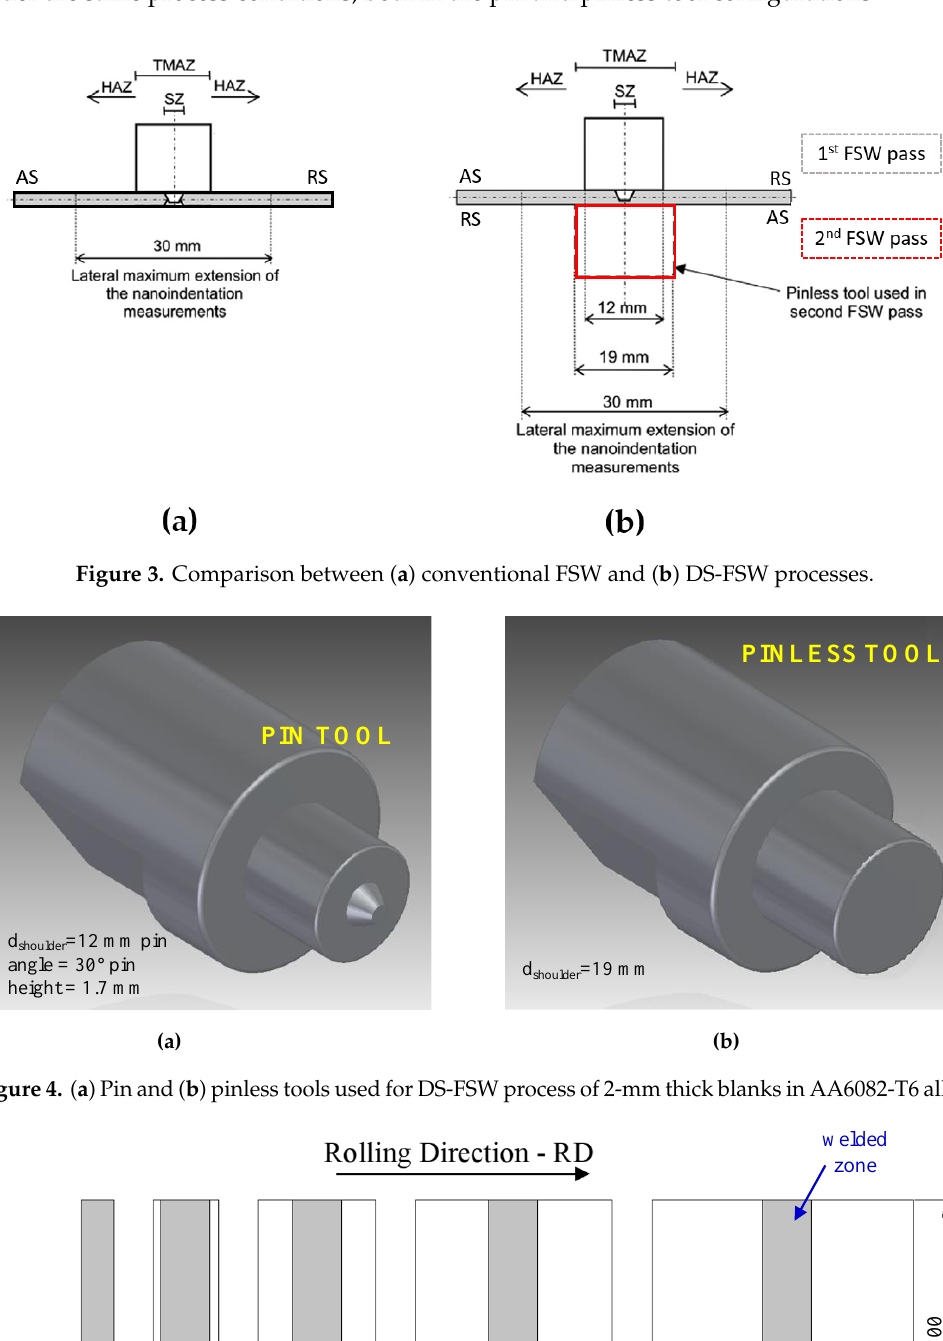
Figure 5. Welded samples used for the hemispherical punch test (data are reported in mm).